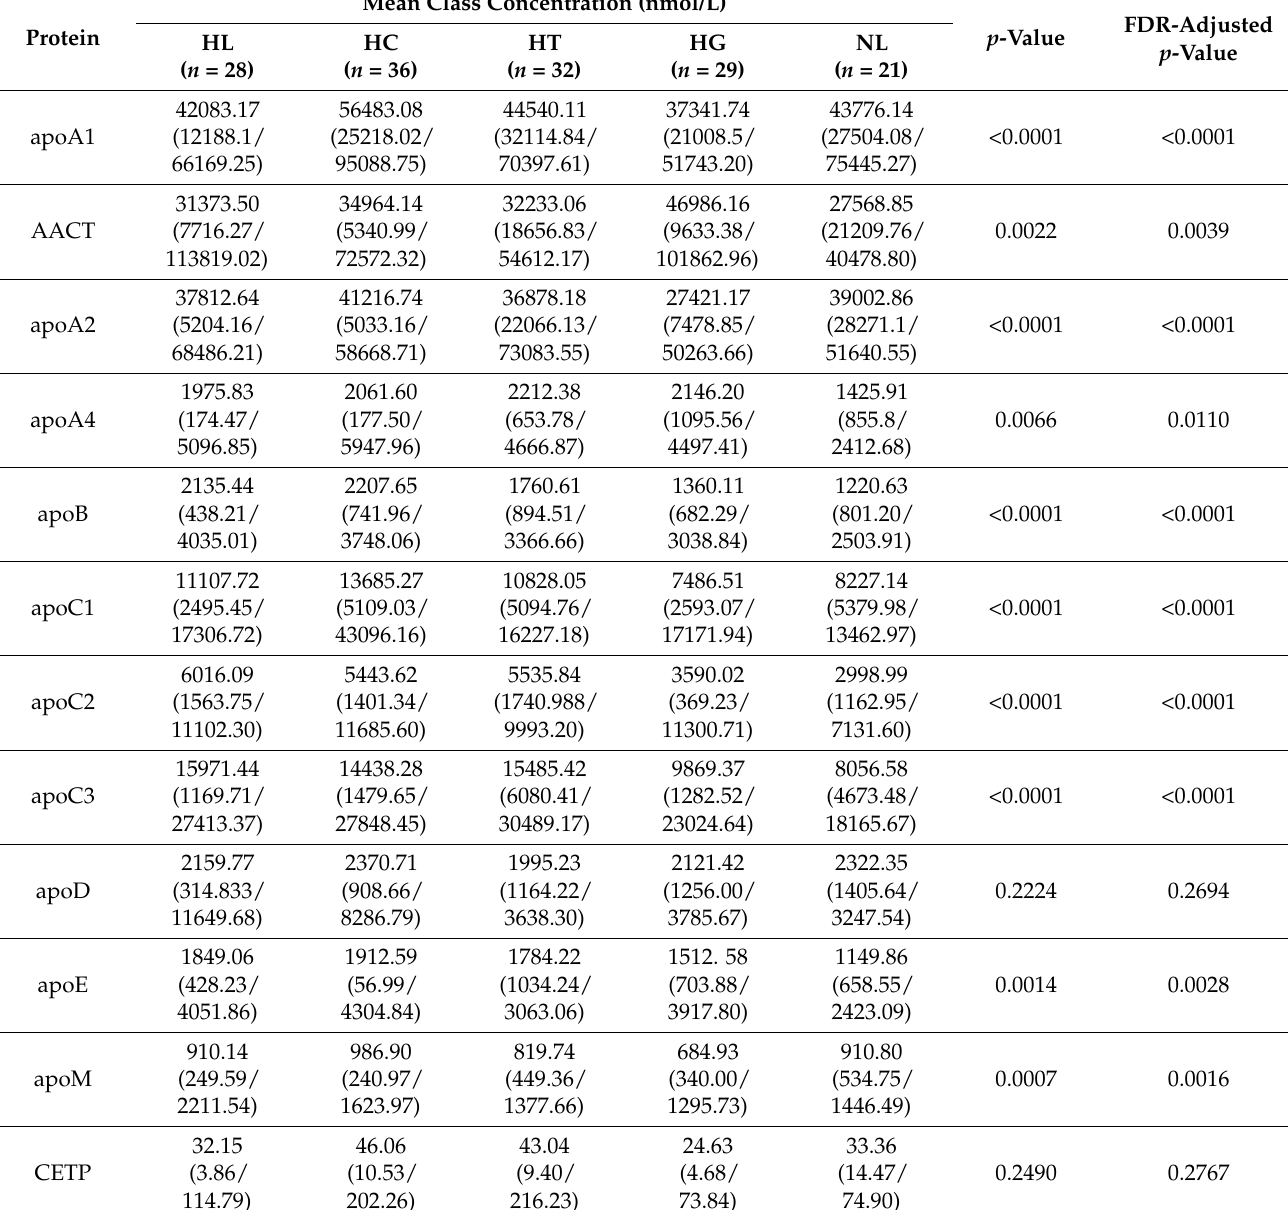
Table 2. Comparison of protein concentrations for the metabolic groups. Average of measured protein concentrations (min/max). One-way ANOVA test was used to determine statistically significant differences between sample groups ( p -value <0.05 was considered